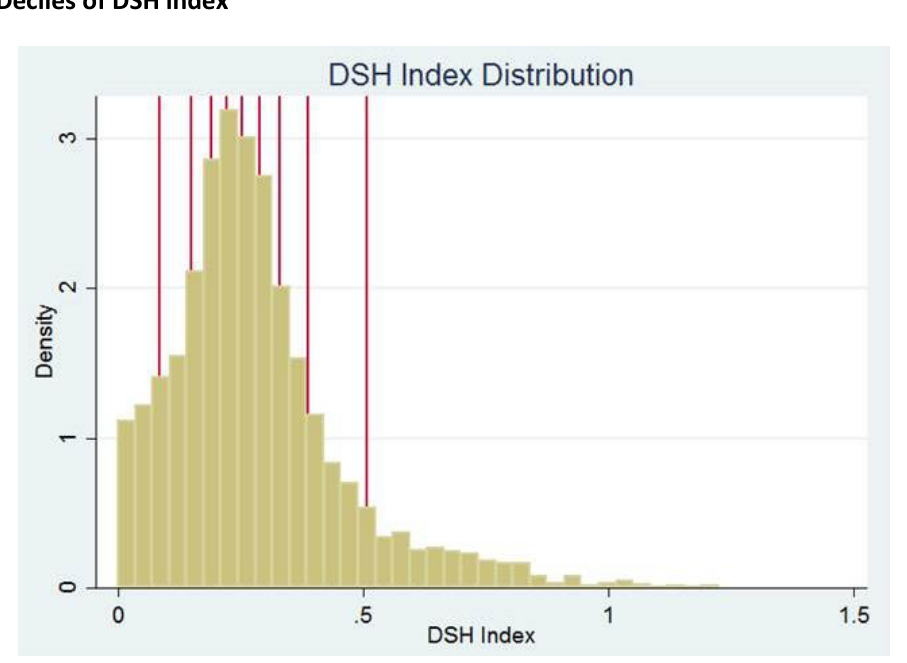
Figure 5.4: Deciles of DSH